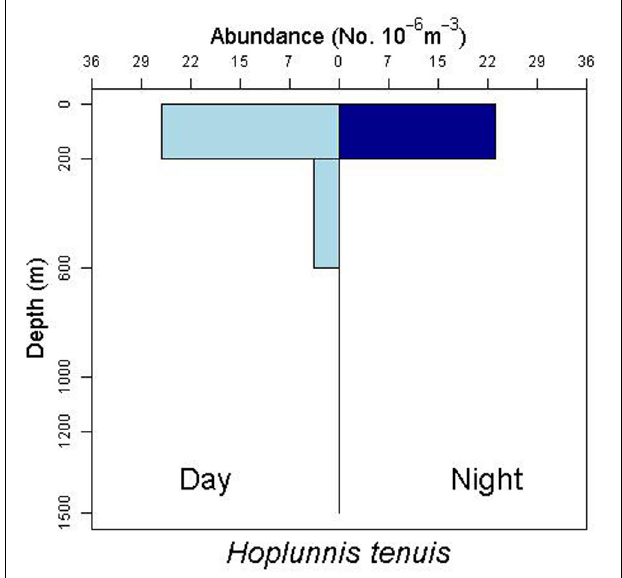
FIGURE 6 | Depth profile for the muraenid leptocephalus species complex Gymnothorax ocellatus/nigromarginatus/saxicola , which show less difference in day vs. night abundances.